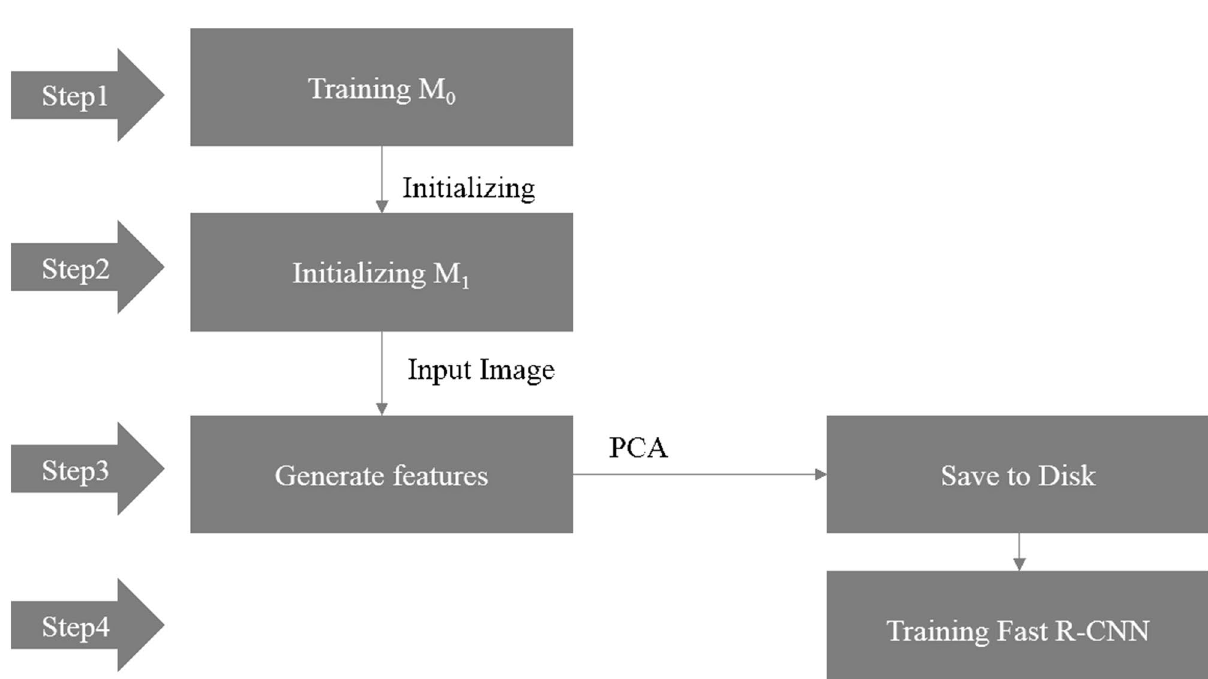
Figure 4. Training process of the PCA-based Faster R-CNN. Drawn by